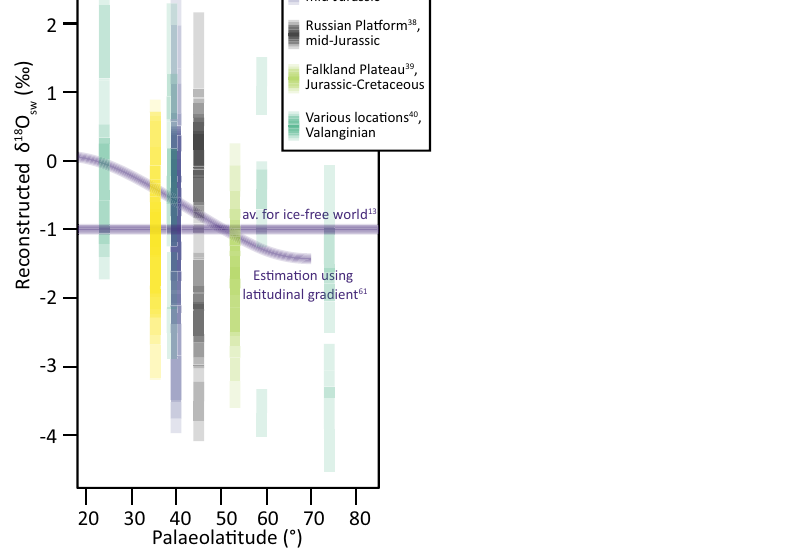
Figure 3. Reconstructed δ 18 O sw based on clumped isotope temperatures using the Kele et al. 27 equation according to palaeolatitude, compared to the average δ 18 O sw for an ice-free world 13 , and the equation proposed by Alberti et al. 62 . This equation may only be applied up to 70° 62 . Data from belemnites and ammonites from this study (bivalves excluded as they may represent bottom water conditions), and belemnites from published Jurassic clumped isotope studies. Mid-Jurassic Russian Platform data (upper Callovian to lower Kimmeridgian; Cylindroteuthis and Pachyteuthis belemnites analysed) from Wierzbowski et al. 38 . Upper Jurassic—Lower Cretaceous Falkland Plateau data (S. hemisphere; Belemnopsis belemnites analysed) are from Vickers et al. 39 . For both studies, Δ 47 data were calculated using the [ Brand ] isotopic parameters 64 and the temperatures calculated using the Wacker et al. 65 calibration. Mid-Jurassic Hebrides Basin data (upper Callovian to lower Kimmeridgian; Cylindroteuthis and Pachyteuthis belemnites analysed) from Vickers et al. 35 were recalculated to the new I-CDES carbonate-based reference frame 53,54 . Valanginian data (from both northern and southern hemisphere locations; 5 different belemnite genera analysed) from Price et al. 40 . It is not possible to recalculate the older datasets to the new I-CDES reference frame as not enough ETH standards were measured, yet the measured ETH-1 and ETH-3 standards are very close to the I-CDES ETH values, so the data are considered comparable. The different time periods are presented together as the global average will remain -1‰, and the latitudinal δ 18 O sw equation does not take into account palaeogeography. Error bars represent the maximum uncertainty in reconstructed δ 18 O sw by the 95% confidence intervals on the clumped isotope temperatures and the SD of repeat analysis for δ 18 O bel